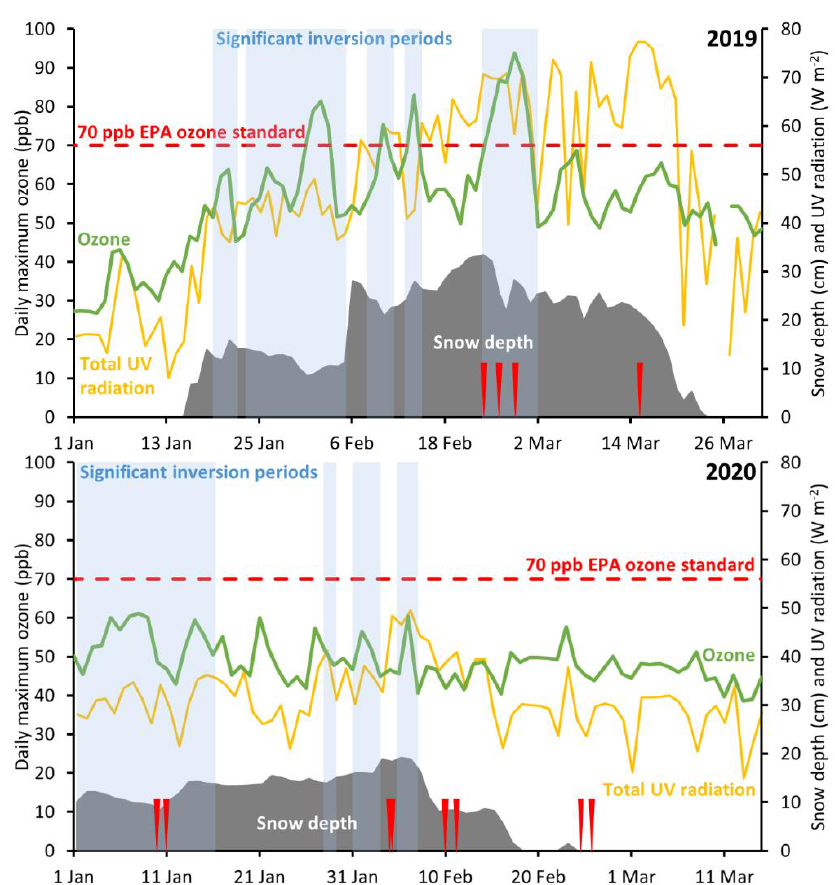
Figure 2. Time series of ozone, snow depth, significant inversion periods, and total daytime UV radiation (UV-A + UV-B, incoming + outgoing) at the Horsepool monitoring station during winters 2019 ( top ) and 2020 ( bottom ). Periods during which samples were collected at portable stations are indicated by red ticks. A collection on 17 April 2019 is not shown.